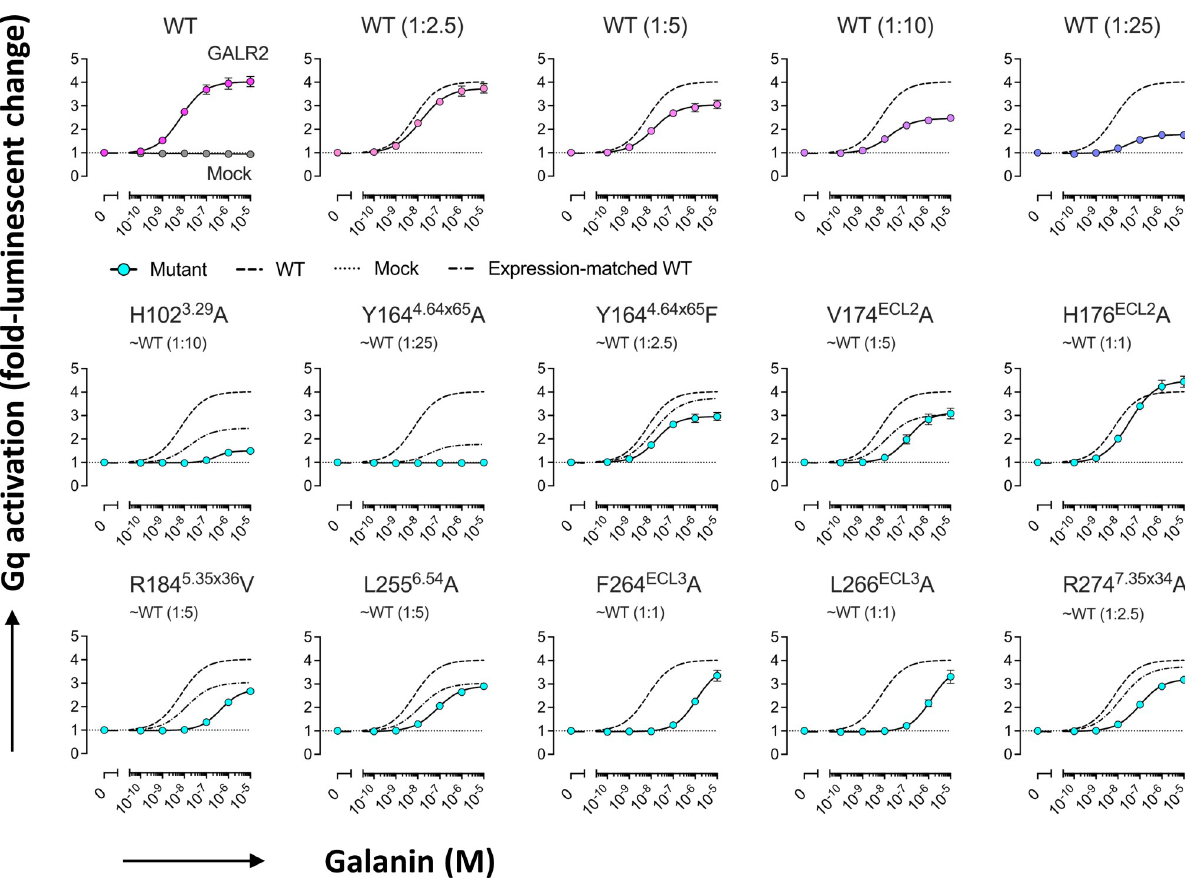
Fig 3. Gq-signaling activity of GALR2 mutants. Galanin-induced Gq-signaling activity of WT GALR2 (titrated plasmid volume) and mutant GALR2 was assessed by the NanoBiT Gq-PLC β assay. Symbols and error bars indicate mean and SEM, respectively, of 3 independent experiments with each performed in duplicate. The dashed lines, the dotted lines, and long dashed dotted lines represent response curves of WT, mock transfection, and surface expression–matched WT, respectively. Surface expression levels of WT and the mutants both of which contained the N-terminal FLAG- epitope tag were assessed by the flow cytometry using a FLAG-epitope tag antibody (S4A Fig). Note that, in many data points, error bars are smaller than the size of symbols and thus are not visible. The data underlying this figure can be found in S1 Data. WT, wild type.